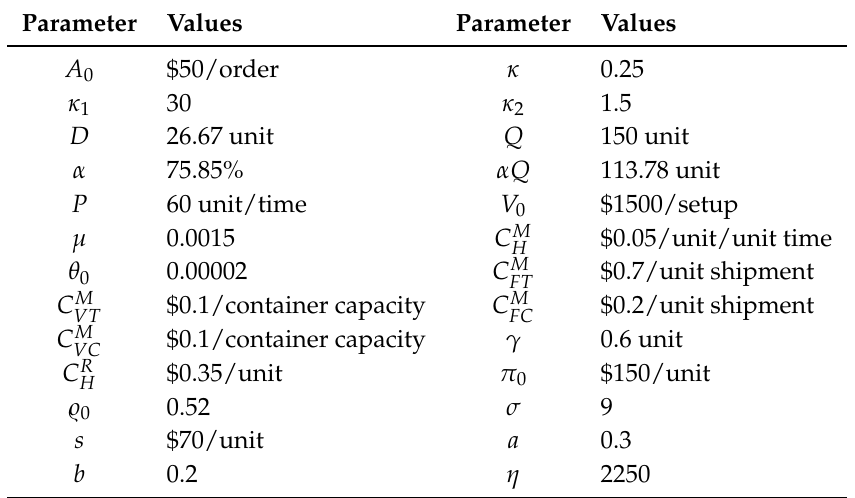
Table 3. Values of the